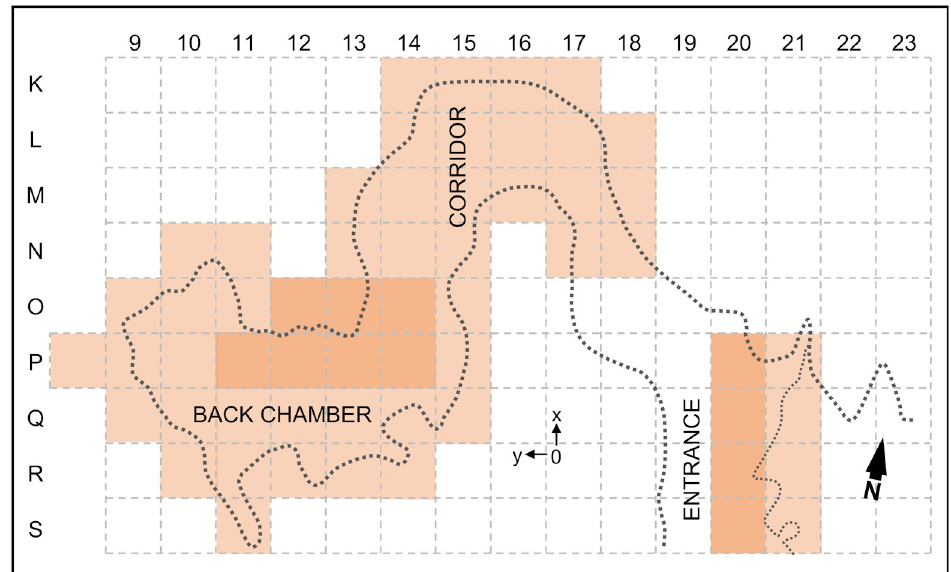
Fig 3. Plan and grid. Plan of the cave at the elevation of the sedimentary infill prior to excavation, and one-square- meter grid used during the 1979–88 field seasons. The excavated grid units are highlighted; the darker shading indicates those where the Early Upper and Middle Palaeolithic levels were